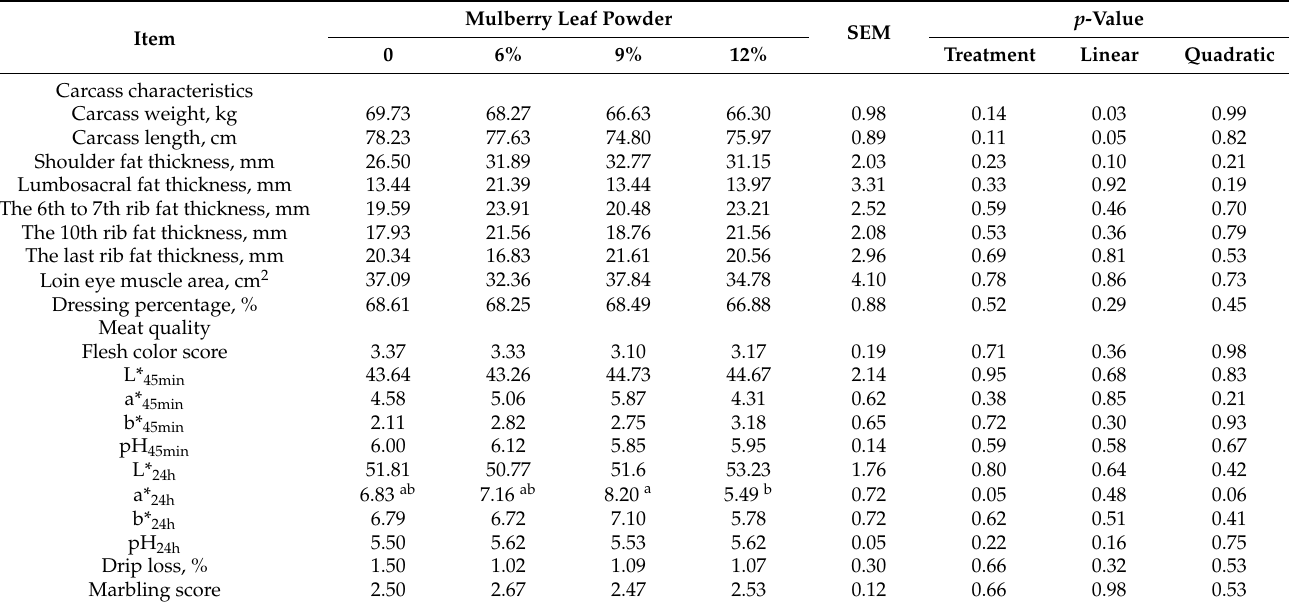
Table 5. Effect of mulberry leaf powder of varying levels on carcass characteristics and meat quality in finishing pigs.